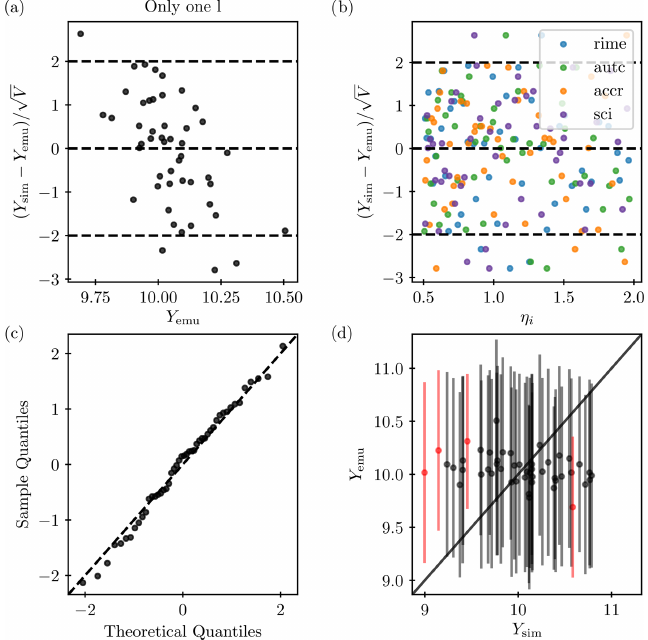
Figure D3. Validation of the emulated angular amplitude spectrum of degree l = 3 for the LWP (see Fig. D2), which failed because of diagnosed